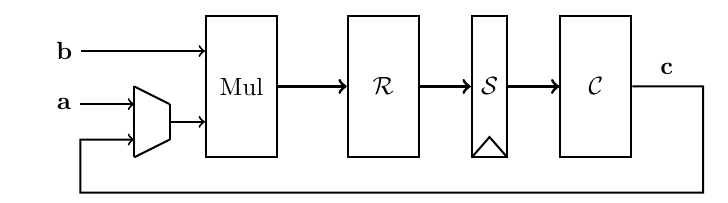
Figure 15: Iterative multiplication following the concept of GLM with refresh layer R , synchronization layer S , and compression layer C